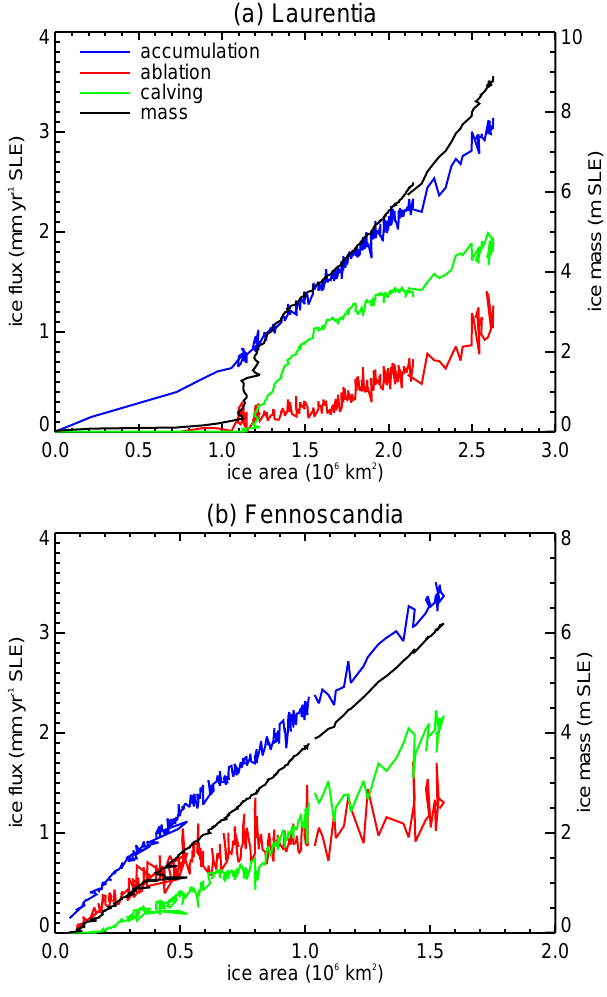
Fig. 14. Components of ice-sheet mass balance in the incipient glacial experiments integrated over the time-dependent ice-sheet area in each domain and shown as functions of that area. The first 25ka of the timeseries are 100-yr means from the 1 : 10 experiment, the remainder are 1000-yr means from the 1 : 100 experiment.